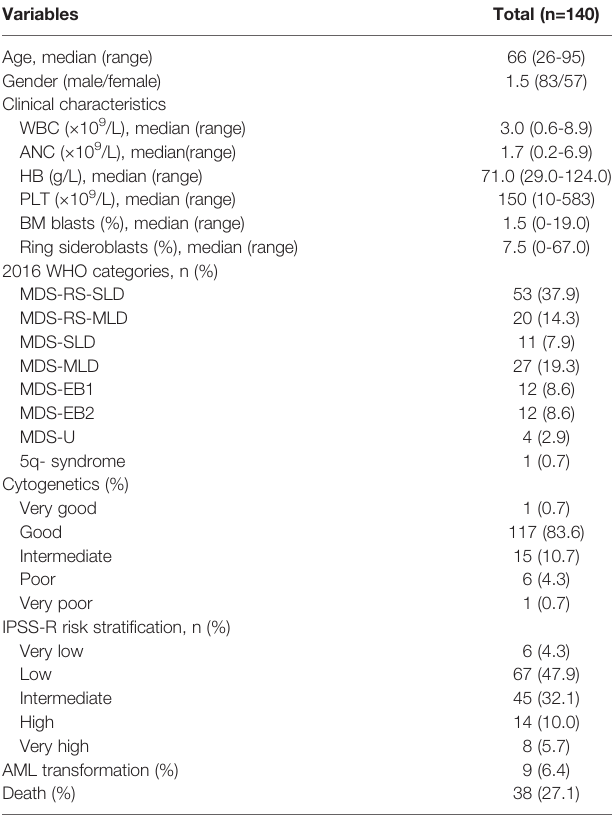
TABLE 1 | Clinical and laboratory characteristics of 140 MDS patients with SF3B1